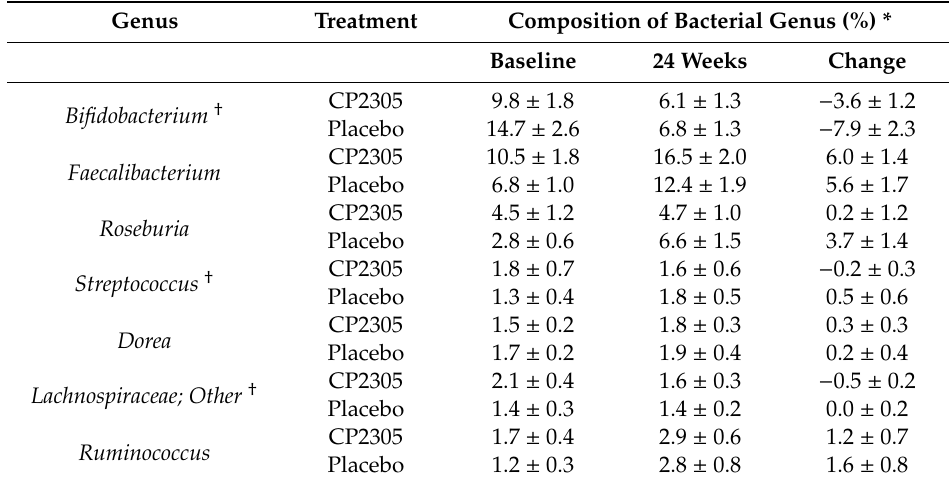
Table 4. Relative abundance of major genera within the fecal microbiota.